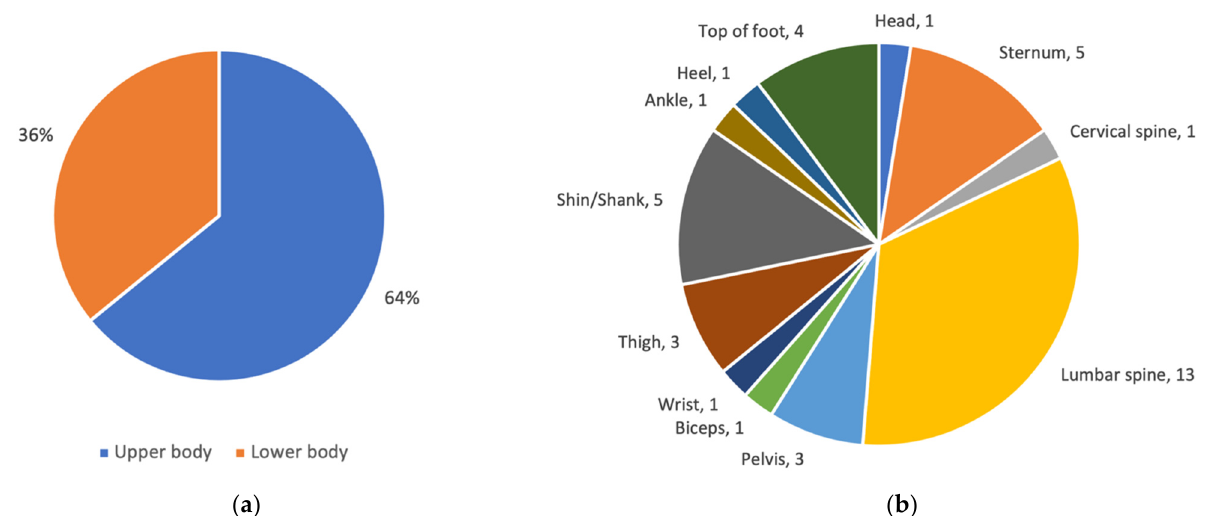
Figure 6. Information on sensor locations for articles in Table 4, i.e., the articles performing discrimination by feature selection: ( a ) Distribution of sensors located at the upper or lower body; ( b ) Number of sensors per body location.